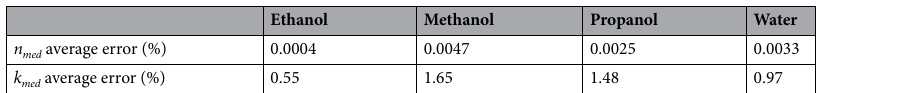
Ethanol Methanol Propanol Water n med average error